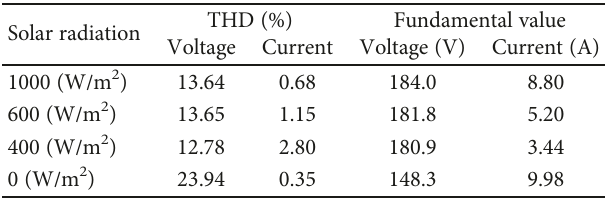
Table 3: Total harmonic distortion under di ff erent solar radiation conditions.